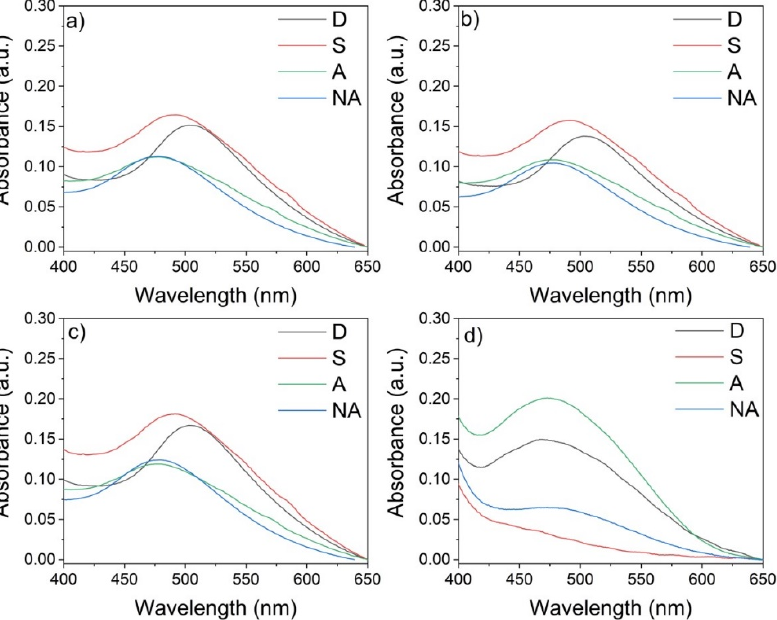
Figure 2. UV-Vis absorption spectra of a mixture of D , S , A or NA with: ( a ) 1 · 4PF 6 , ( b ) 2 · 4PF 6 , ( c ) 3 · 4PF 6 and ( d ) 4 · 4PF 6 in 2.5 mL of DMSO:H 2 O (4:1). The spectra show the corresponding charge-transfer absorption